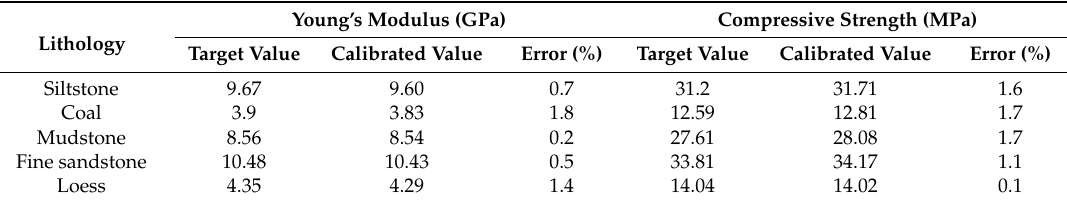
Table 3. Calibrated Young’s modulus value and the compressive strength value in the UDEC model.